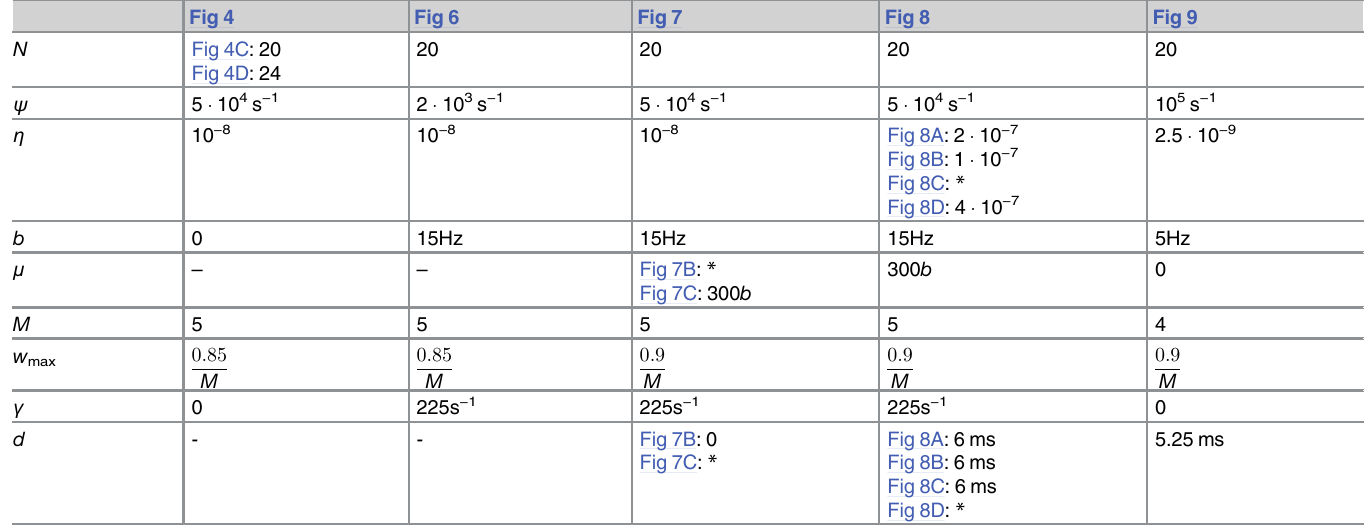
Table 2. Simulation parameters. Fig 4 Fig 6 Fig 7 Fig 8 Fig 9 Fig 4C: 20 Fig 4D: 24